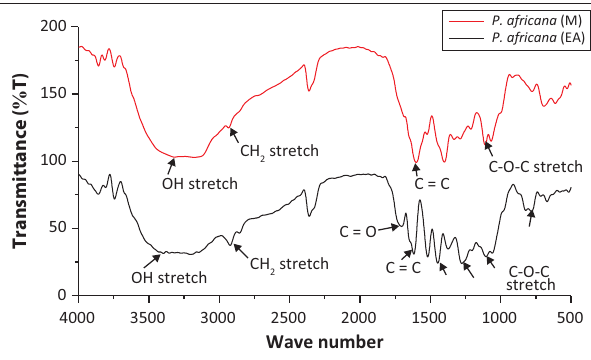
FIGURE 1: Fourier transform infrared spectra of Prunus africana